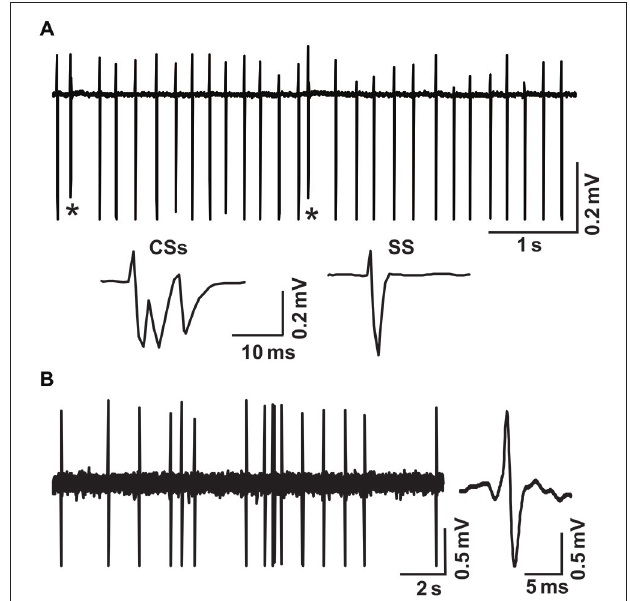
FIGURE 1 | Cell-attached recordings showing the characterization of cerebellar cortical PCs and MLIs in vivo in mice . (A) Upper, representative cell-attached recording traces showing the spontaneous activity of a cerebellar PC. Lower, enlarged traces of CSs and a simple spike (SS). CSs are indicated by*. (B) Left, representative cell-attached recording traces showing the spontaneous activity of a cerebellar MLI. Right, enlarged traces of spike